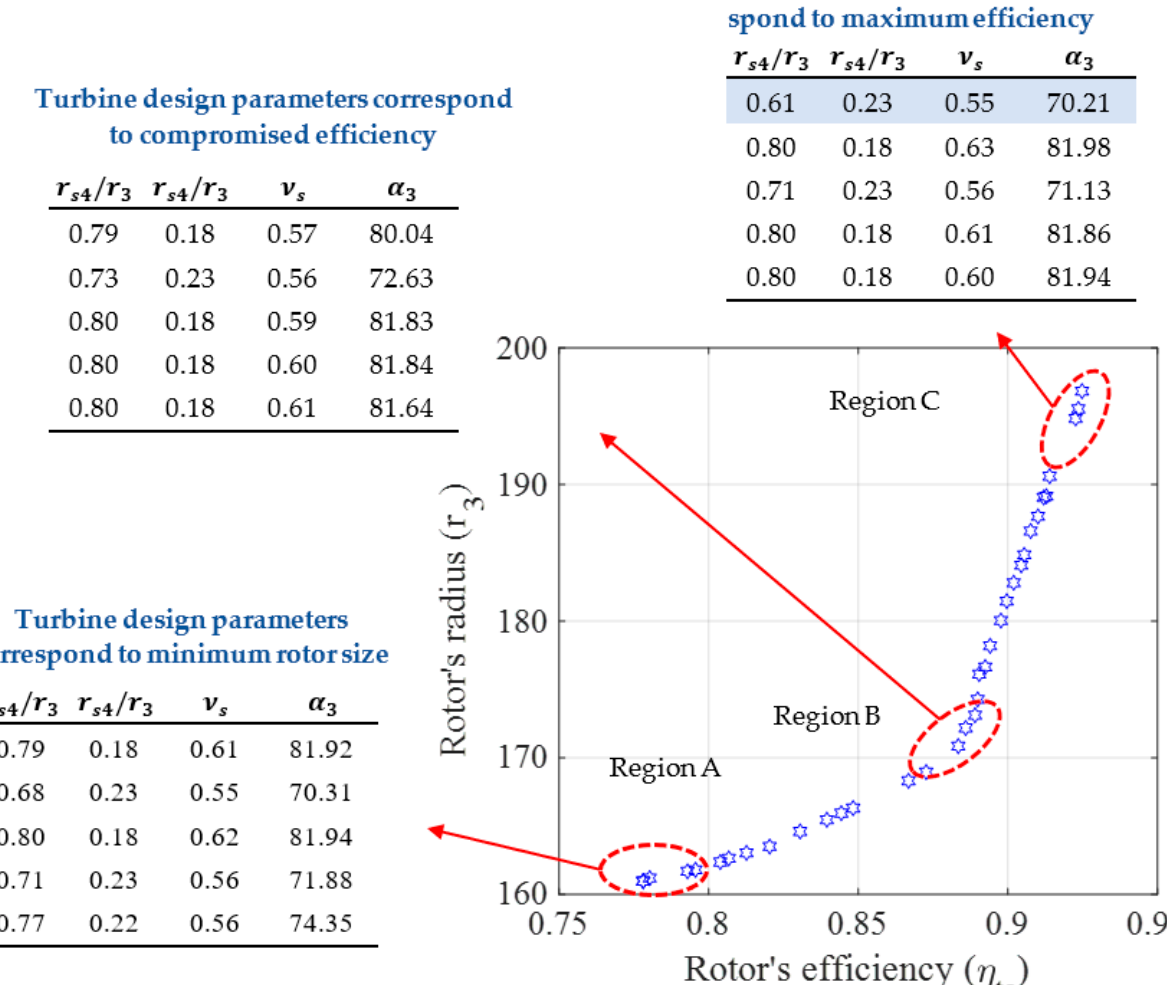
Figure 15. Pareto front computed for rotor’s size and rotor’s efficiency using multi-objective genetic algorithm.